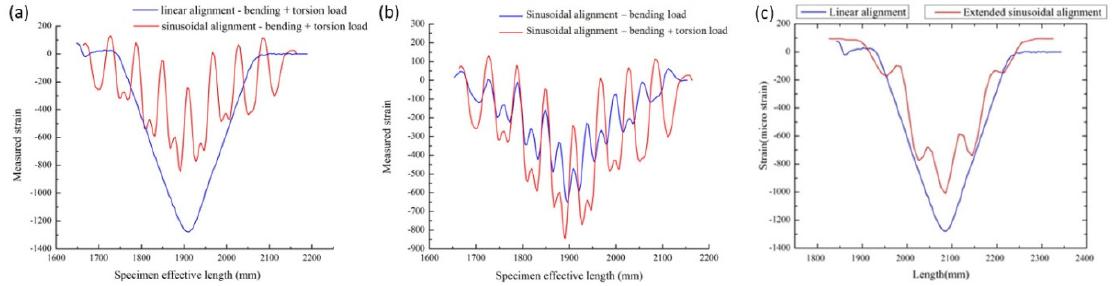
Figure 7. ( a ) Linear vs. sinusoidal alignment, bending + torsional load; ( b ) sinusoidal alignment, bending load with torsion vs. without torsion; ( c ) linear vs. extended sinusoidal alignment, bending load [139] .